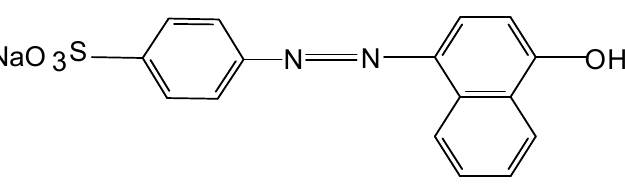
Figure 7. Chemical structure of the azo dye Orange II.